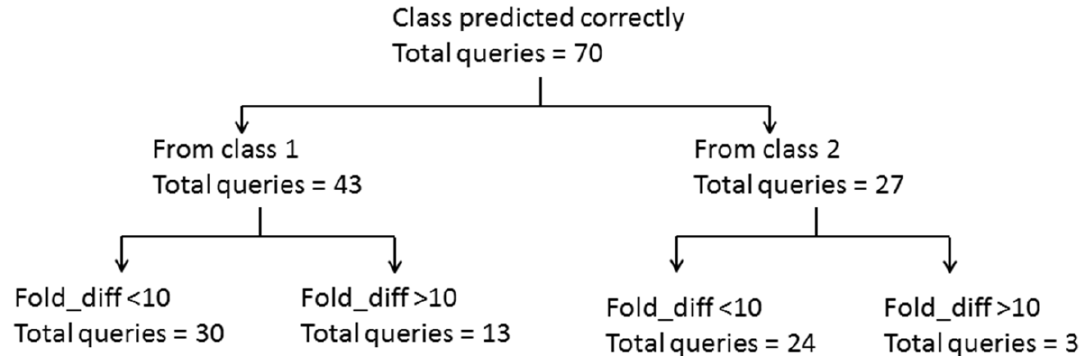
Figure 1. Summary of LOEL prediction for the training set queries from the qualified